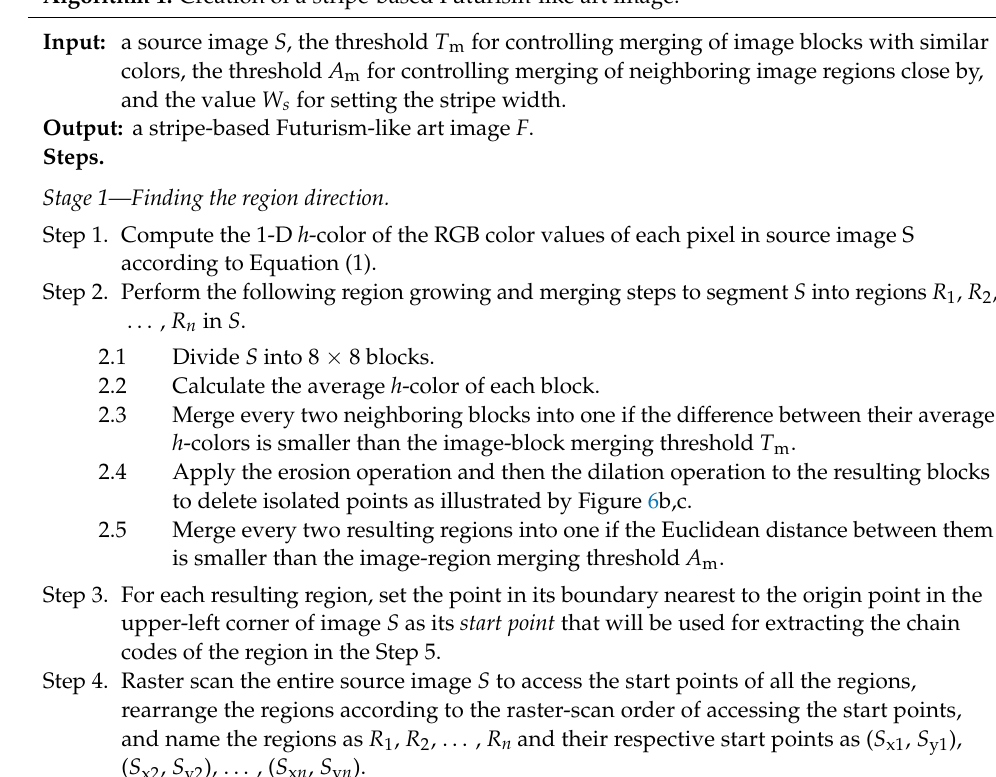
Algorithm 1. Creation of a stripe-based Futurism-like art